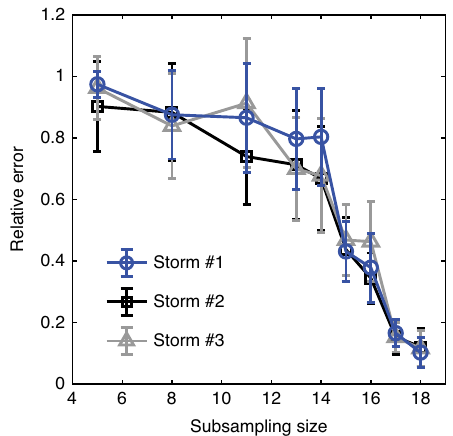
Fig. 3 Relative error as a function of the subsampling size. Relative errors (cid:3) ρ 19 k 2 = k ρ 19 k 2 are de fi ned as k ρ m L 2 L 2 , where the subsampling size inv inv inv varies from 5 to 18. Here, the inversions for storms #1-#3 are performed at 13:20:00 on April 16, 2017 (UTC + 8), 14:10:00 on April 17, 2017 (UTC + 8), and 09:35:00 on April 20, 2017 (UTC + 8), respectively. Error bars denote standard deviation over ten